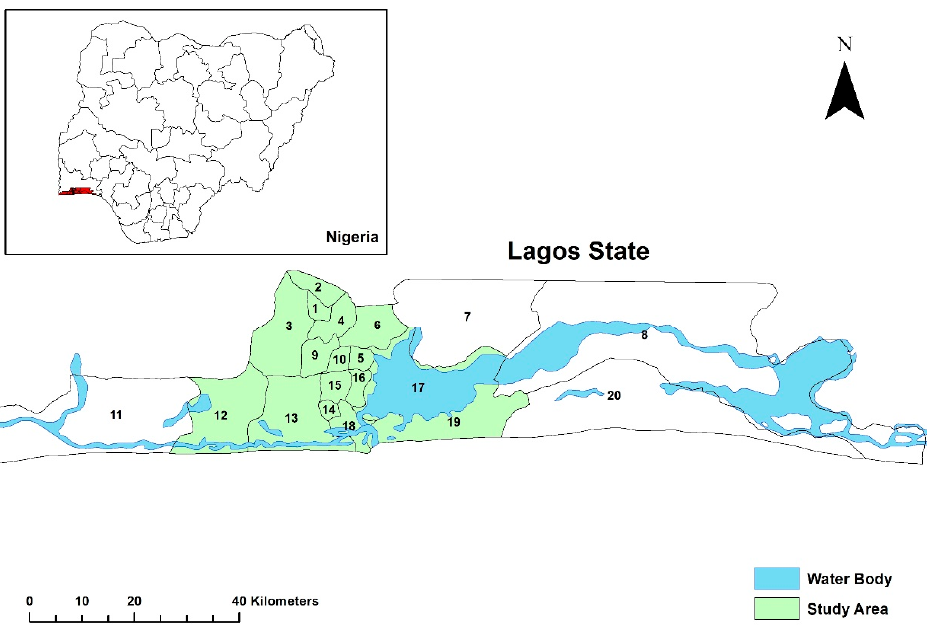
Figure 2. Map of Lagos State showing the area of study (metropolitan region).